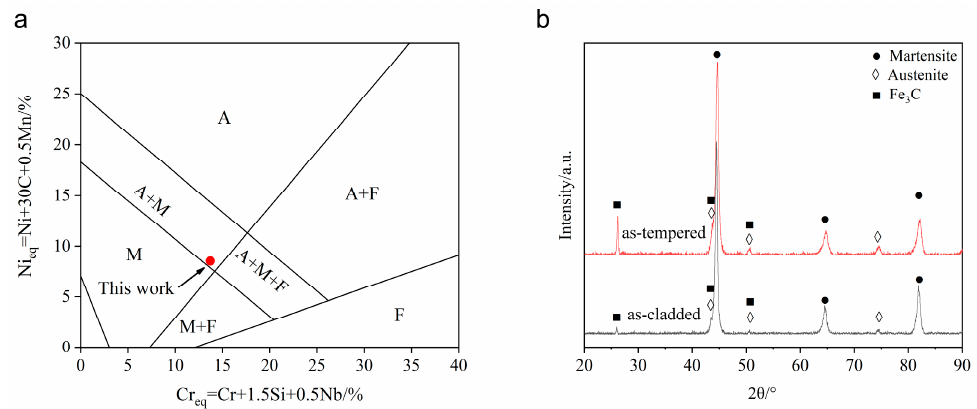
Figure 2. ( a ) Schaeffler diagram of AISI 420 SS powder used in this work and ( b ) XRD patterns of the